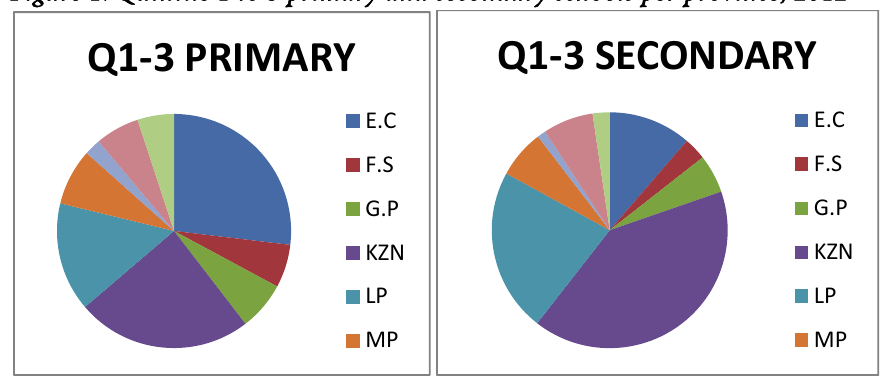
Figure 1: Quintile 1 to 3 primary and secondary schools per province, 2012